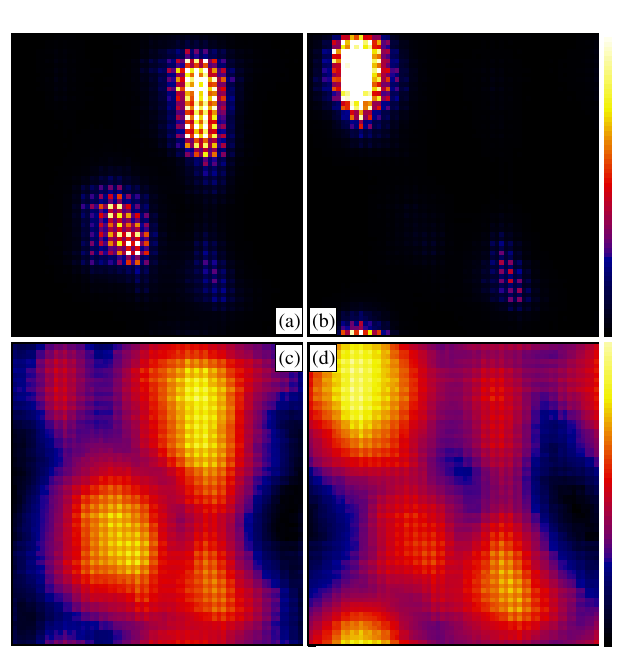
FIG. 27. The total string density ρ in Fig. 26(b) resolved into contributions from the individual A [ ρ in (a) and (c)] and B [ ρ A in (b) and (d)] strings. The scale is linear in (a) and (b), spanning the range [0, 0.003] (and white is used for larger values, up to 0.0097 for ρ and 0.017 for ρ ). In (c) and (d), the same data are A B shown on a logarithmic scale, with the color bar corresponding ∈ ½ − 15 ; − 3 (cid:5) ; ln ð ρ to ln ð ρ A Þ B Þ